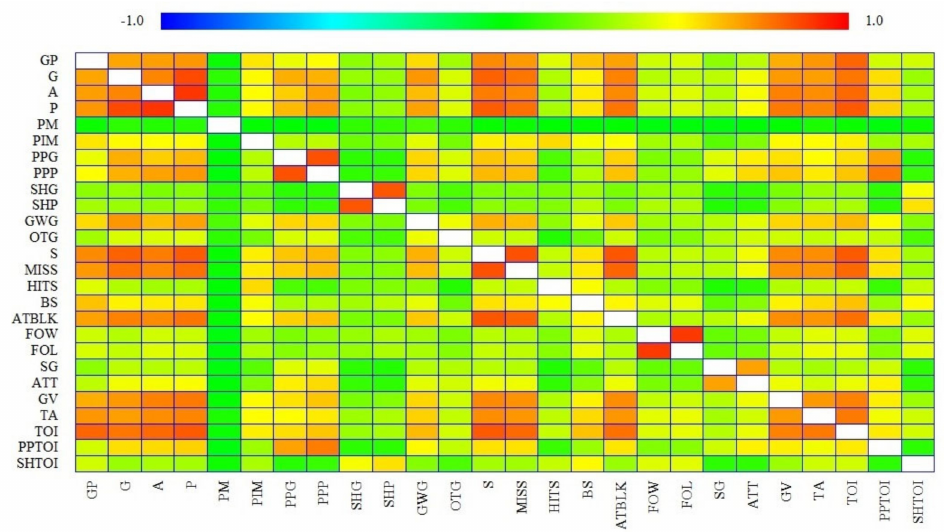
Figure 3. Kendall rank correlation plot of potential attributes.